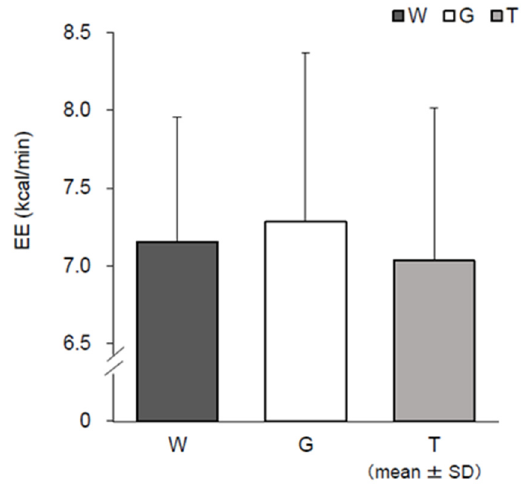
11 of 16 Figure 9. Respiratory exchange ratio ( RER) assessments. W—water; G—glucose; T—trehalose.